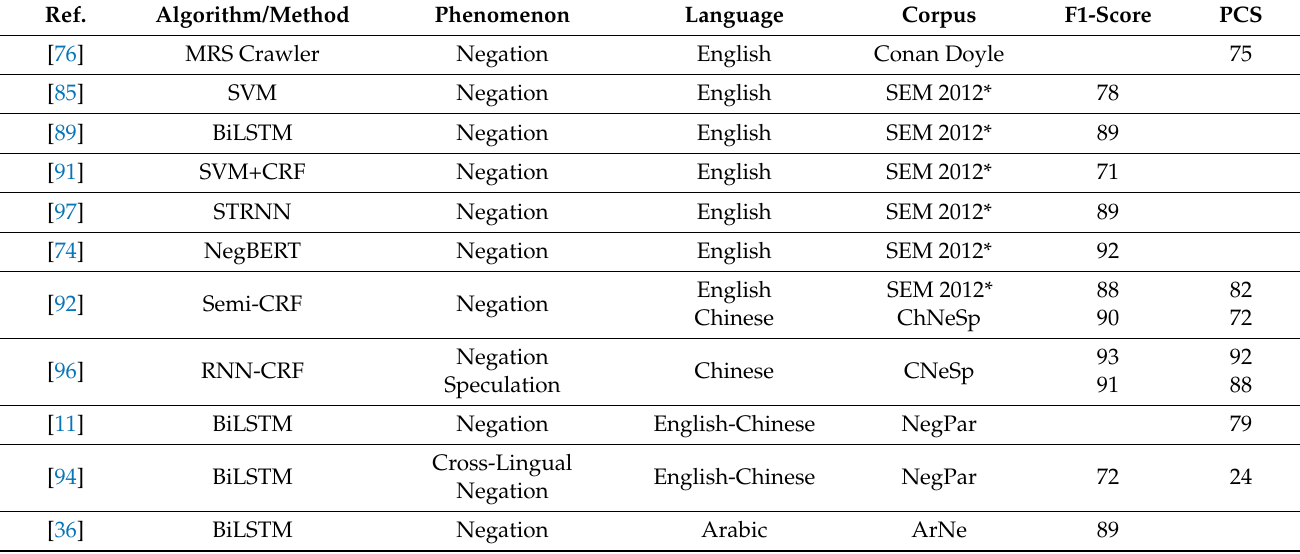
Table 7. Negation and speculation detection systems for other